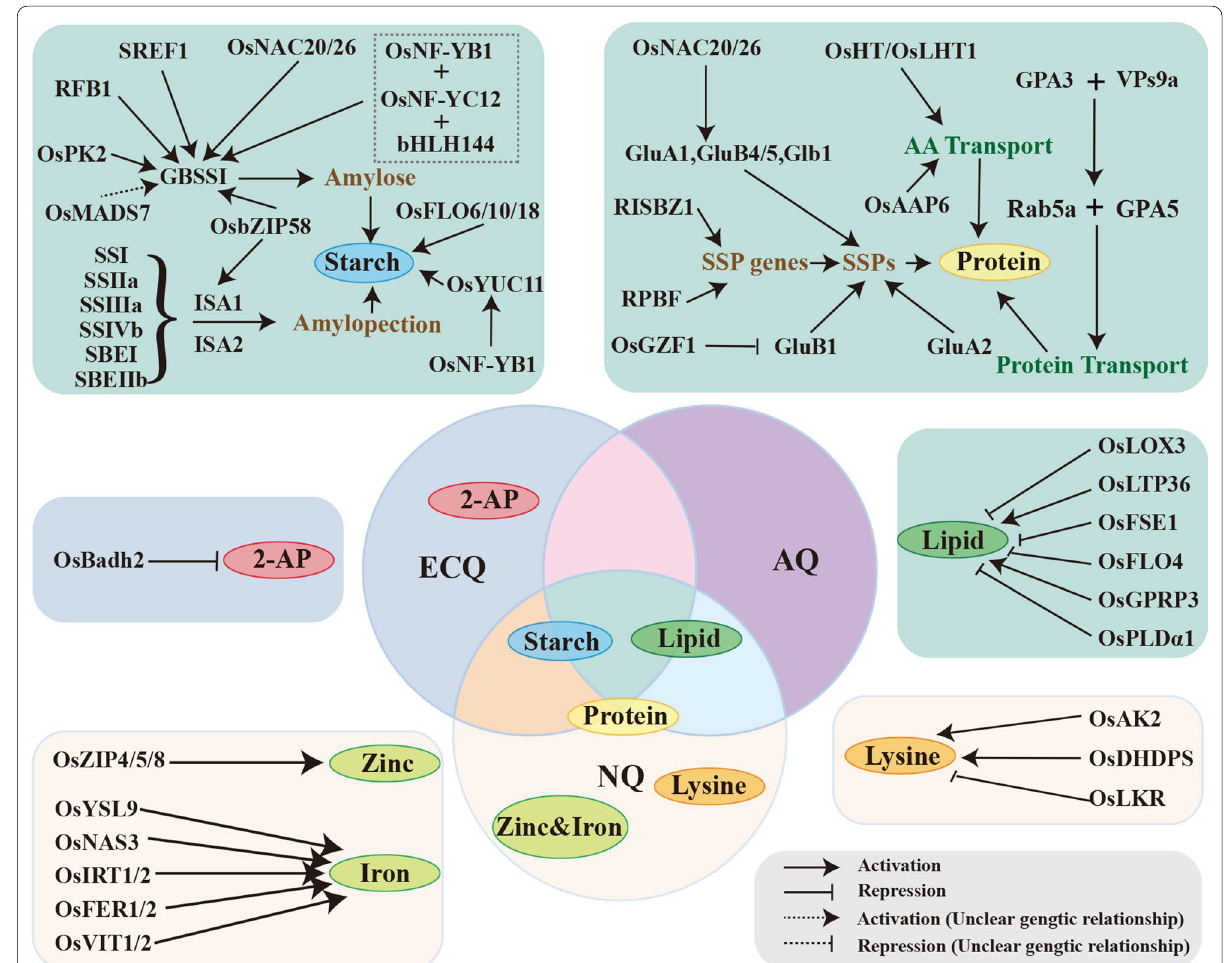
Fig. 4 The genes involved in the synthesis and regulation of the main components of the endosperm, and their contributions to corresponding rice quality traits. The dotted line indicates that an indirect relationship that is supported by genetic evidence, which needs to be further verified. AQ, appearance quality; NQ, nutritional quality; ECQ, eating and cooking